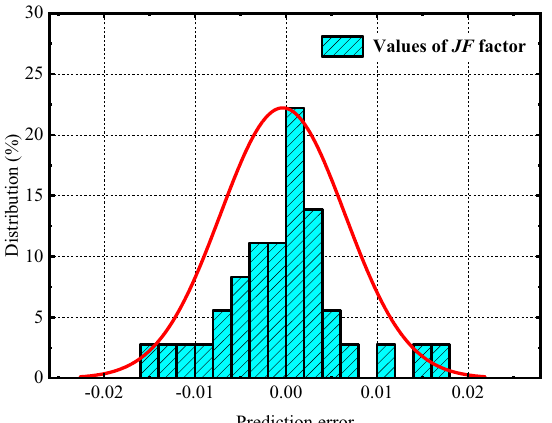
Figure 9 Absolute error distributions of j factor prediction